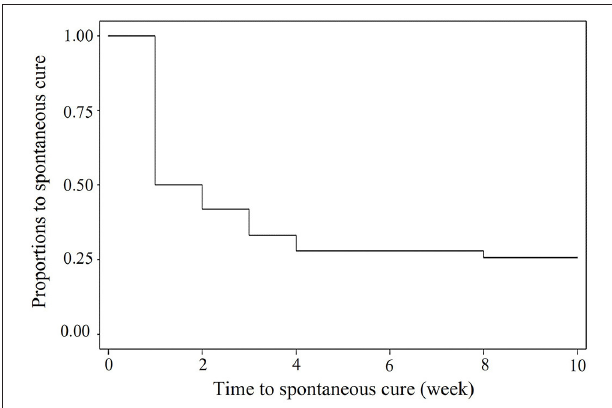
FIGURE 1 | Kaplan—Meier survival curve of duration of field Streptococcus uberis IMI observed during a 10-weeks